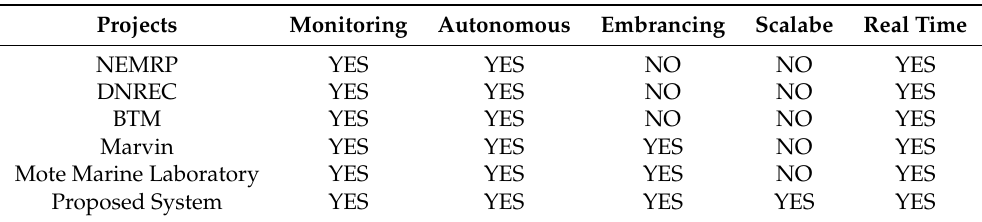
Table 1. Comparison of the proposed system with state of art systems.